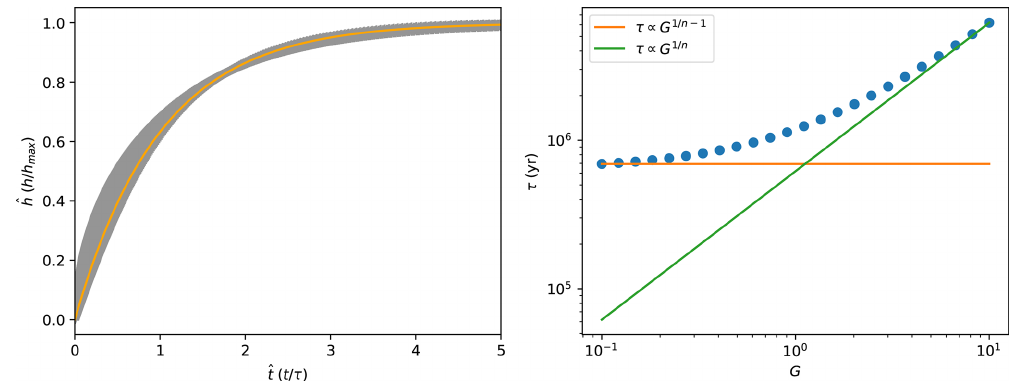
Figure C2. Computed response times for 24 numerical experiments in which the deposition constant, G , of the ξ – q model was varied.